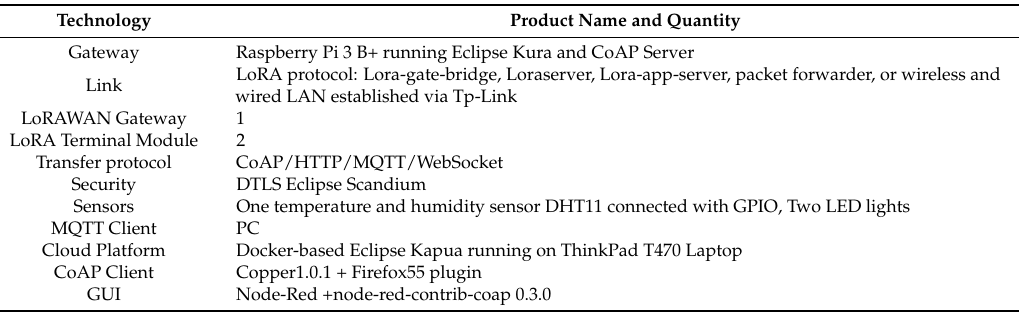
Table 5. Devices list used for